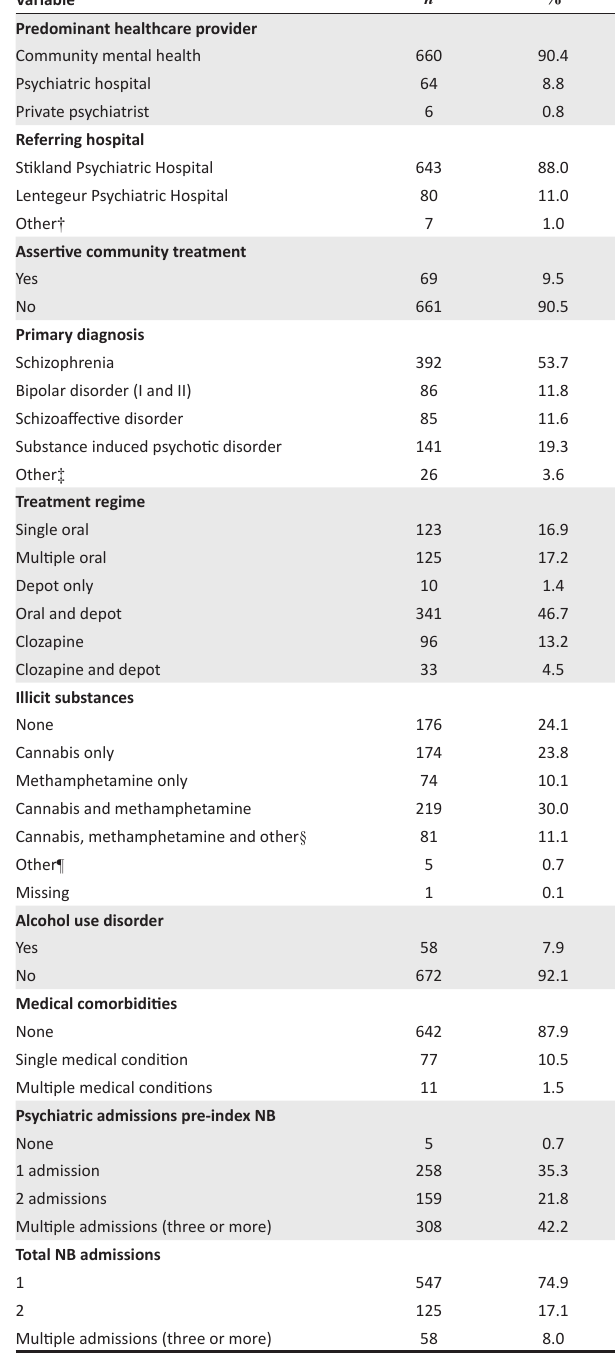
TABLE 1: Service-related data and demographic characteristics of patients ( N = 730) admitted to New Beginnings step-up or step-down facility from